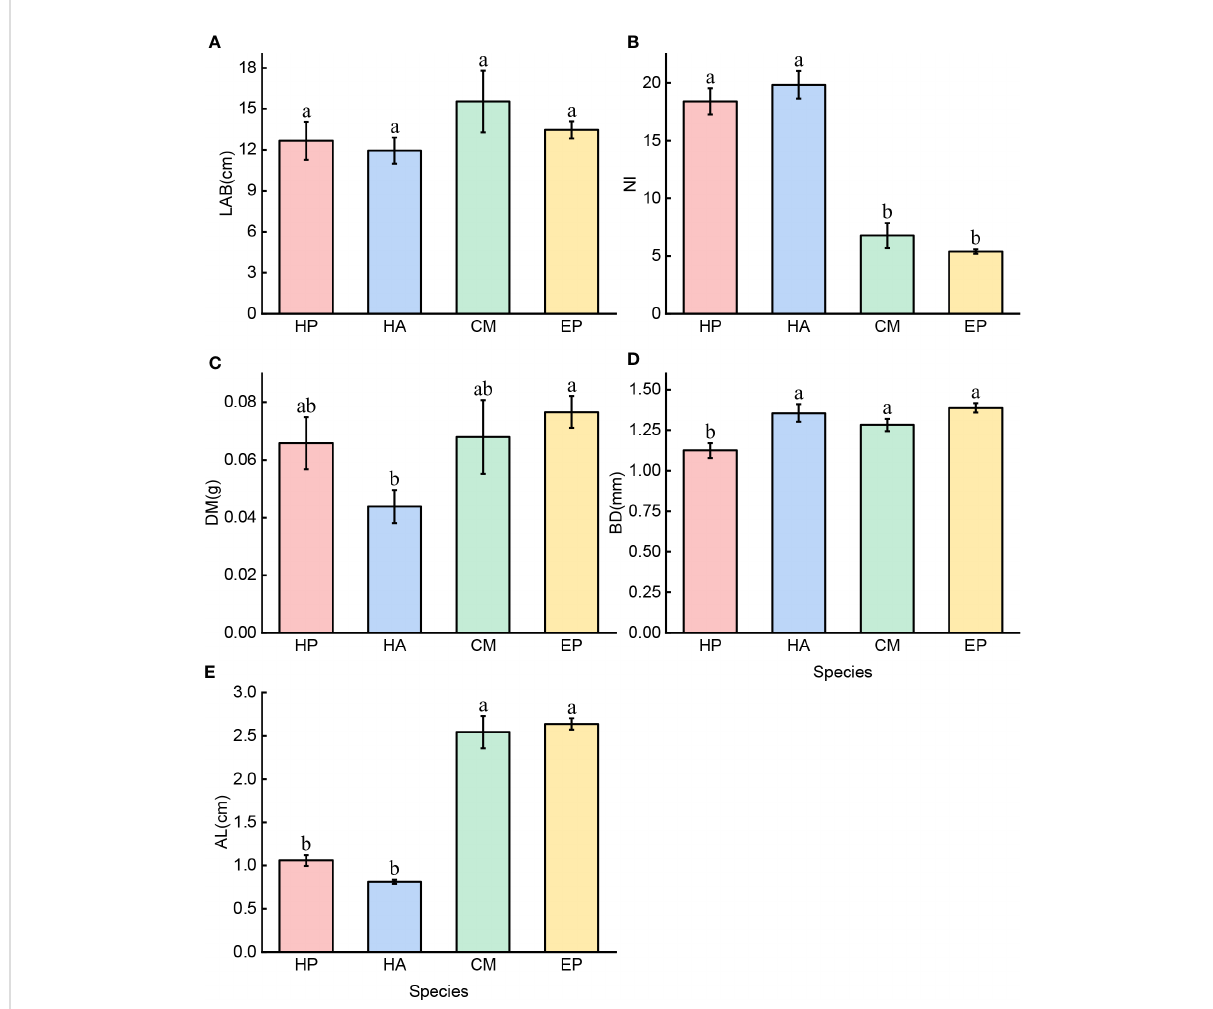
FIGURE 3 Five traits of assimilative branches of four desert shrubs; Species: HP = Haloxylon persicum , HA = Haloxylon ammodendron , CM = Calligonum mongolicum , and EP = Ephedra przewalskii ; Functional traits: (A) LAB = Length of assimilative branches, (B) NI = Number of internodes, (C) DM = Dry mass of assimilative branches, (D) BD = Average basal diameter of assimilative branches, and (E) AL = Average length of the fi rst three internodes of assimilative branches. Different lowercase letters represent signi fi cant differences (P < 0.05). Mean ± SE (n = 6 and